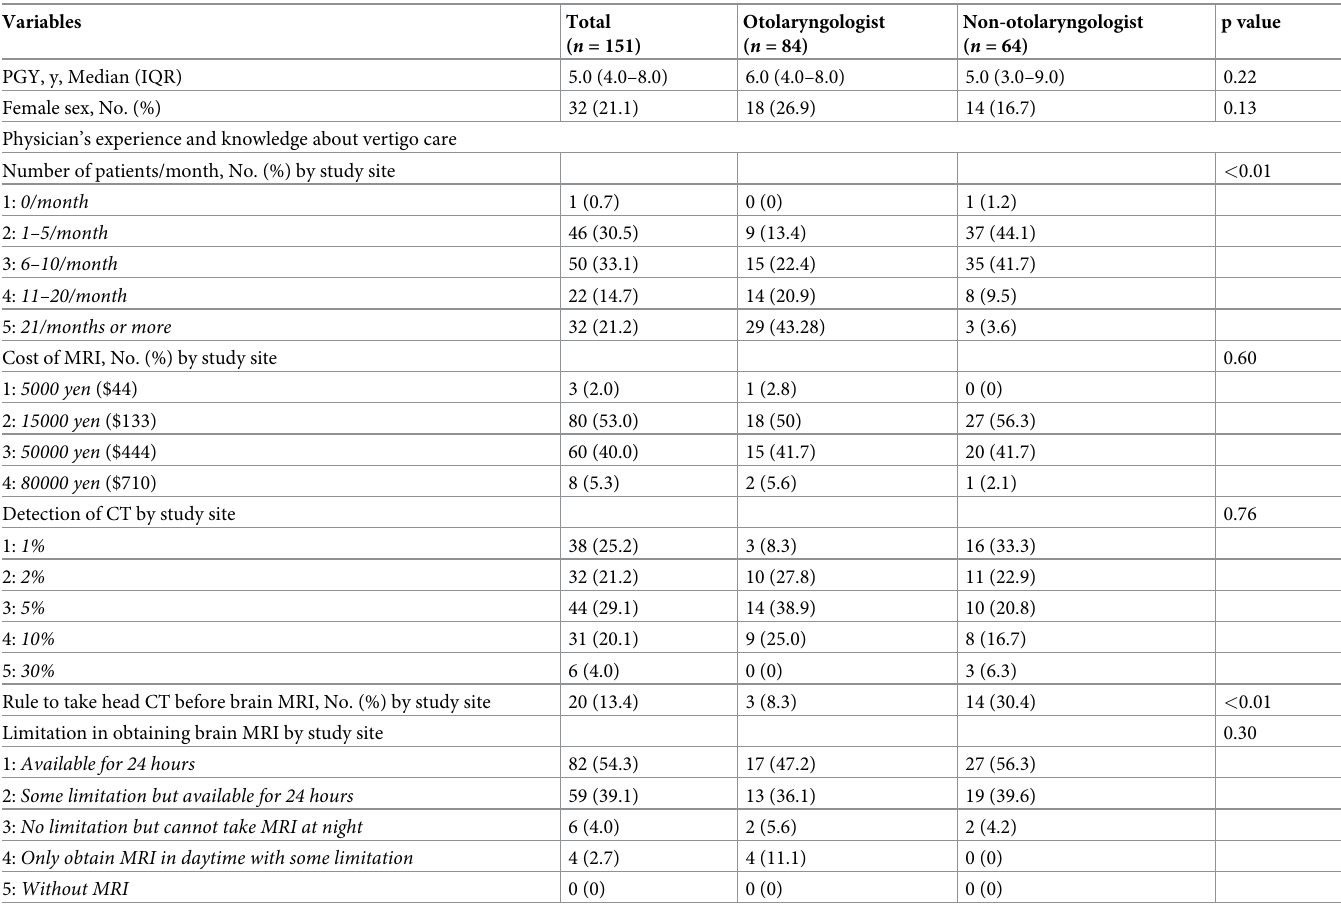
Table 1. Physician characteristics and